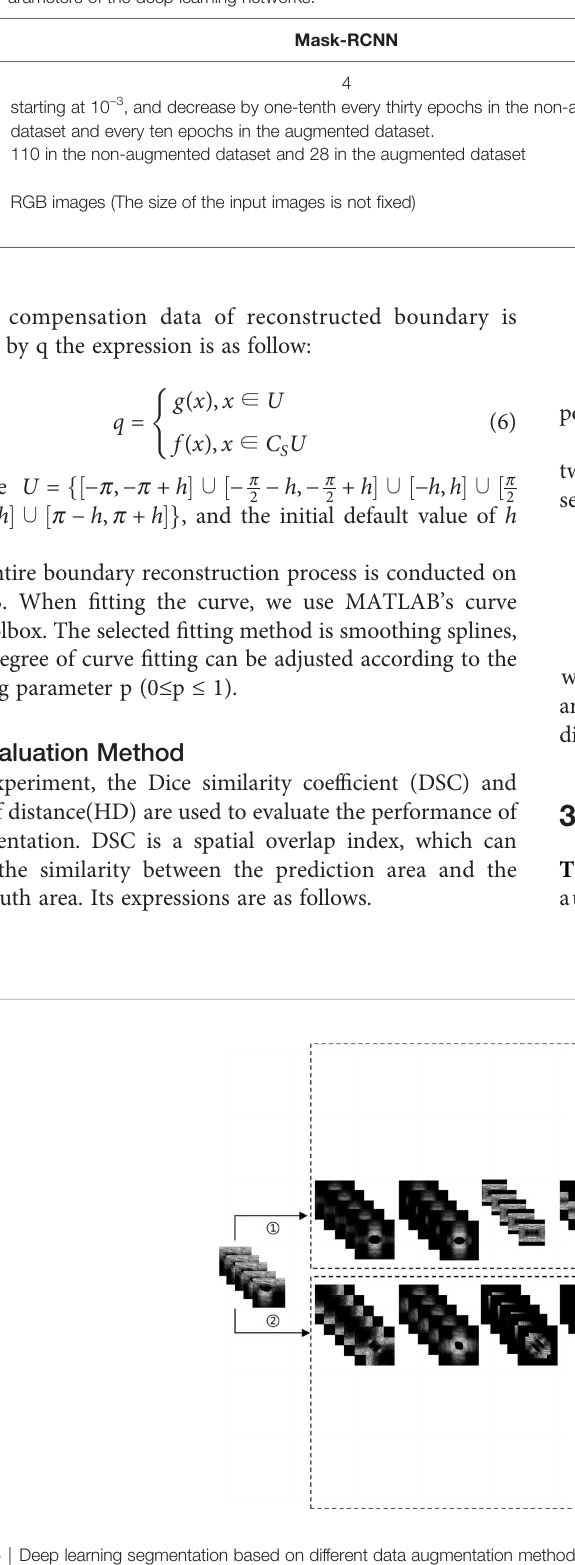
FIGURE 6 | Deep learning segmentation based on different data augmentation methods. ① HVCMA, ② DCMA, ③ deep learning network training, ④ segmentation prediction of the testing case.